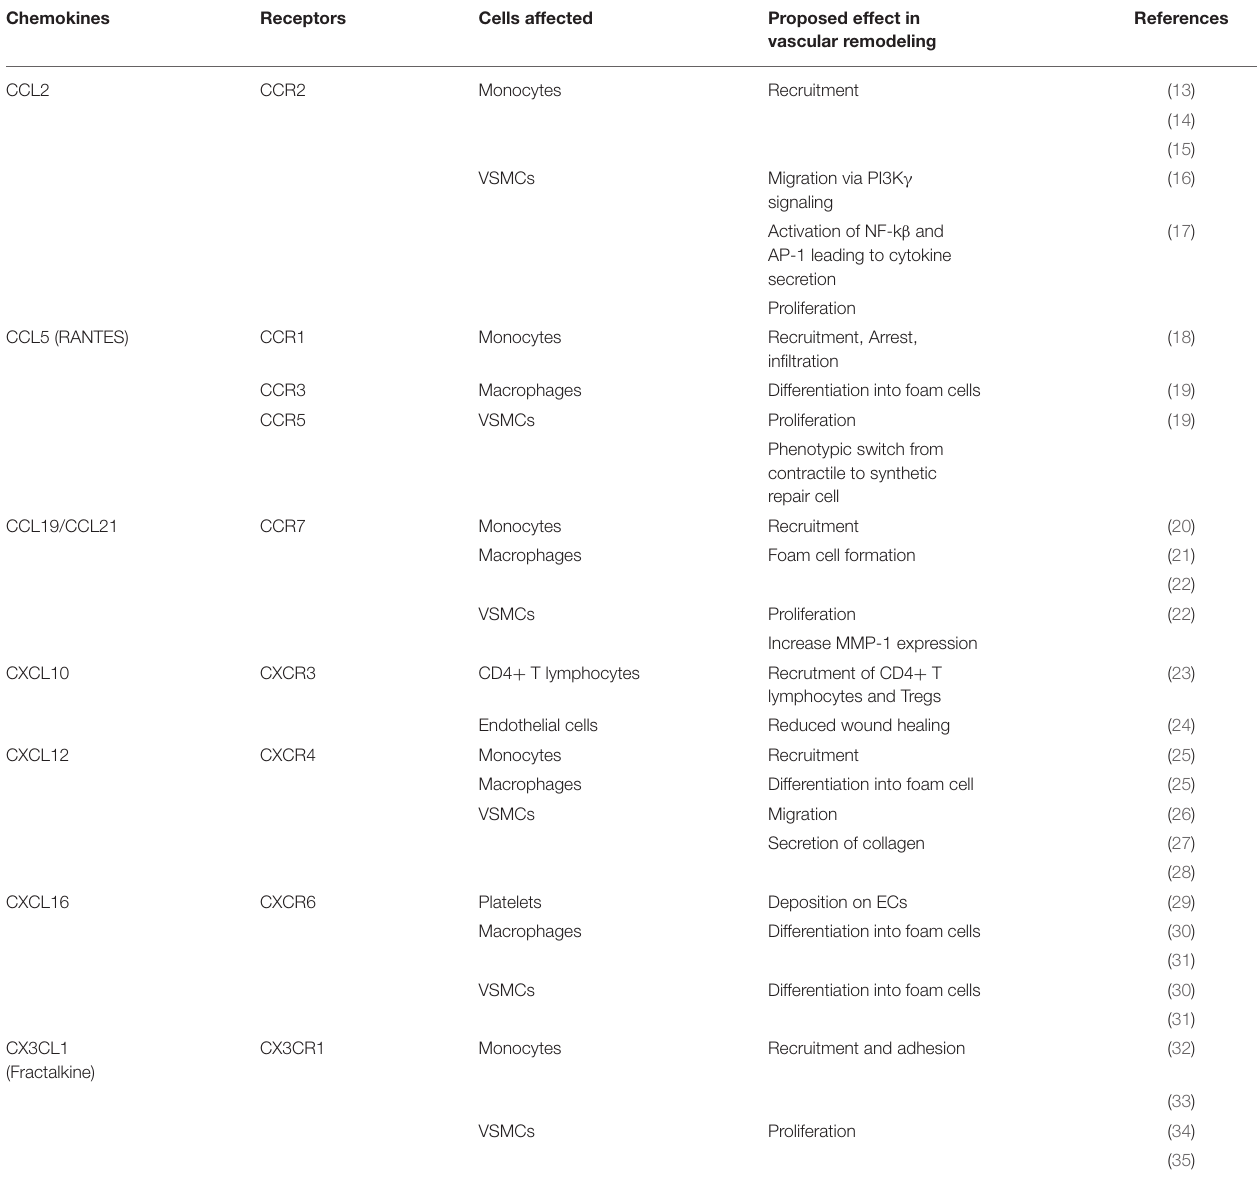
TABLE 1 | Overview of chemokines involved in atherosclerosis remodeling and their physiological effect.